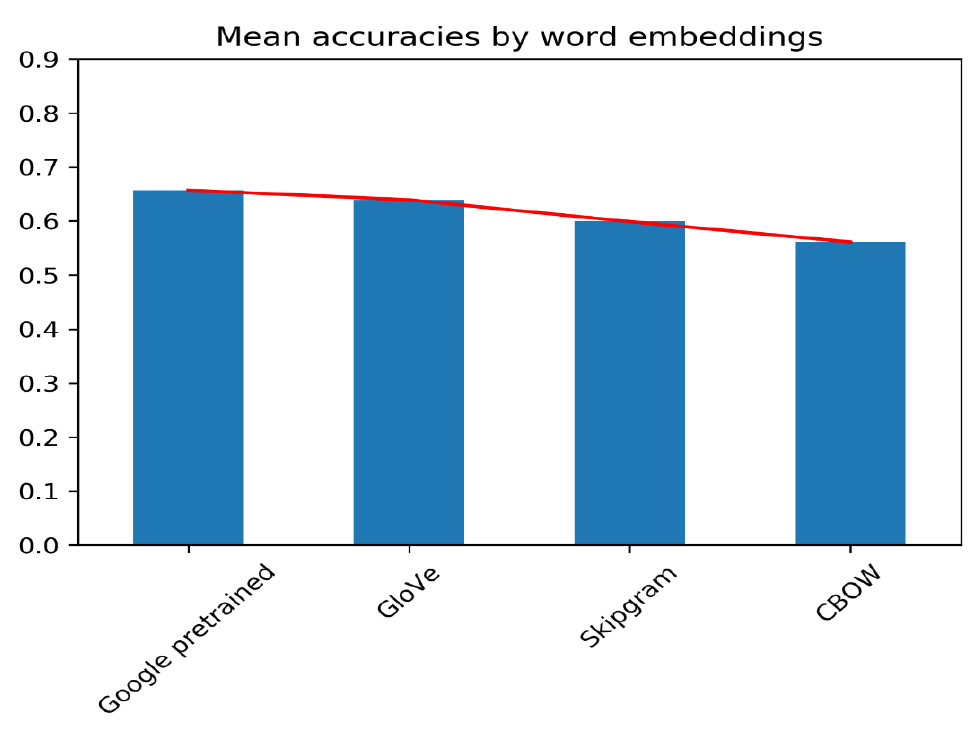
Figure 11. Mean F 1 scores for all the word embeddings. Software